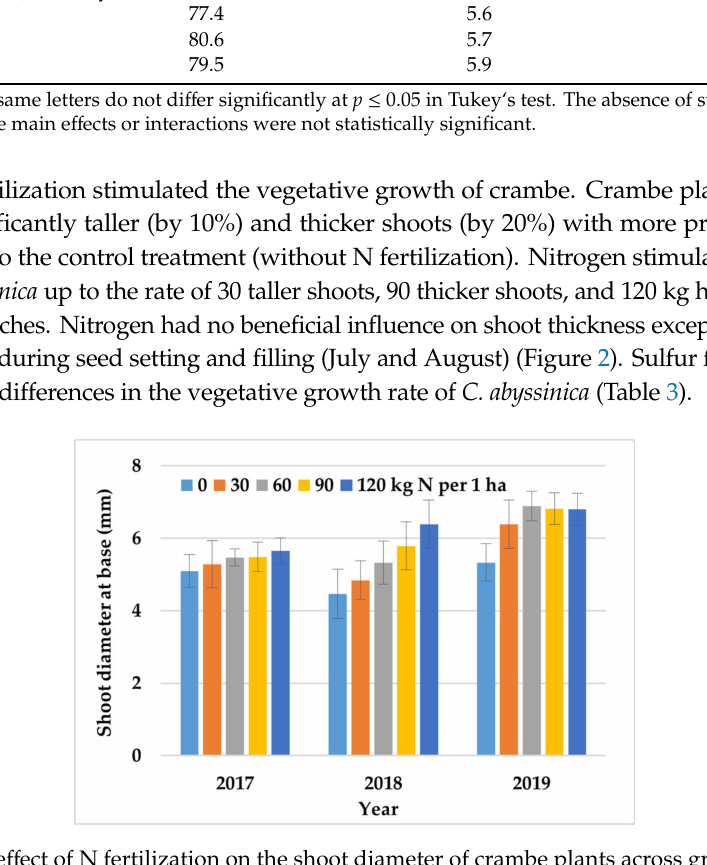
Figure 2. The e ff ect of N fertilization on the shoot diameter of crambe plants across growing seasons (2017–2019). Error bars represent the standard deviation.